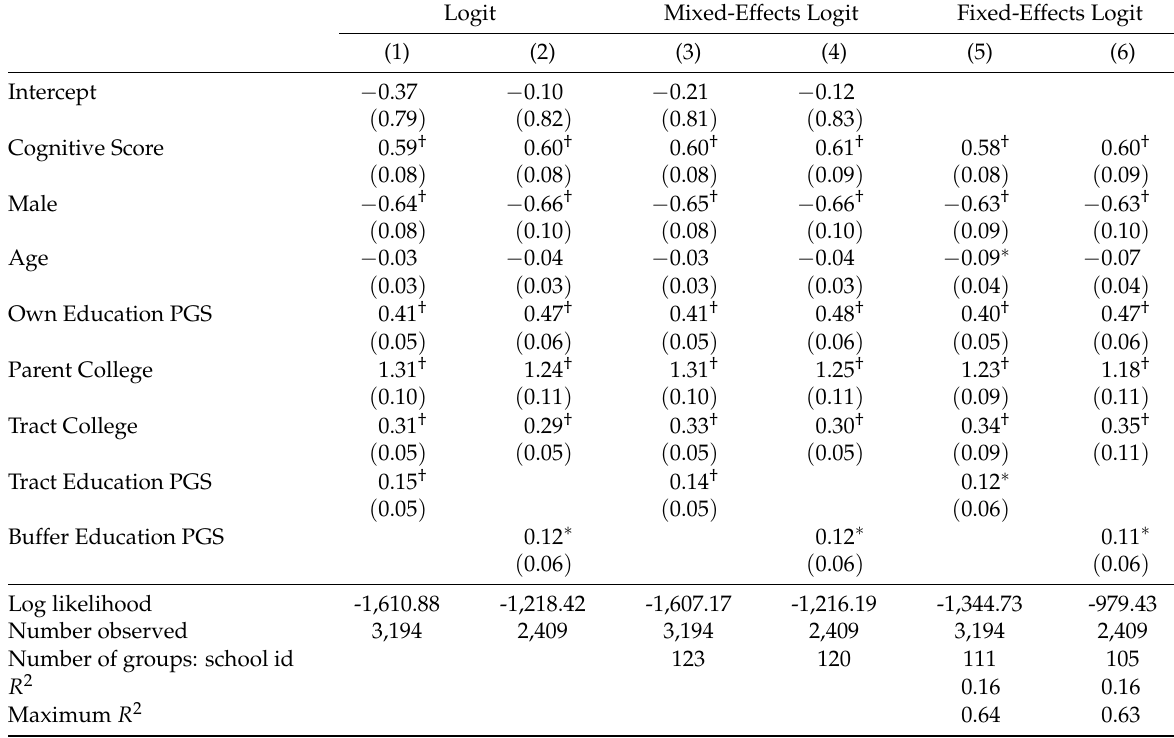
Table 4: Degree attainment at wave 4; logit